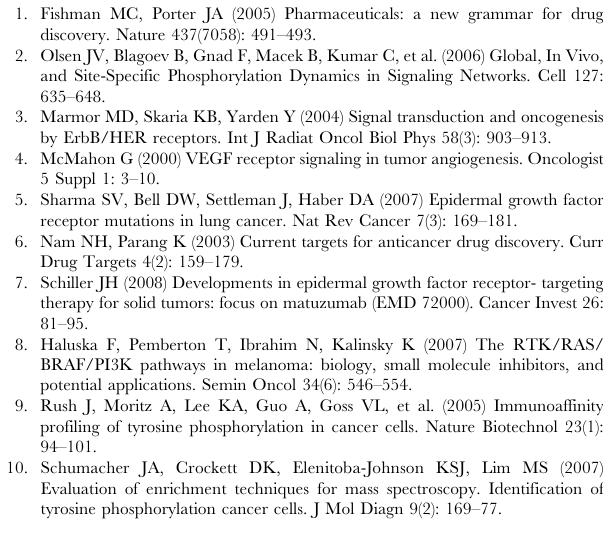
Table S2 Human orthologs and paralogs with conserved Y residues that are phosphorylated in Drosophila proteins. Summary of all the conserved tyrosines on human proteins. The details of each conserved tyrosine which includes the protein domain of tyrosine location, function, subcellular location, tissue specificity and information on disease phenotypes are given.